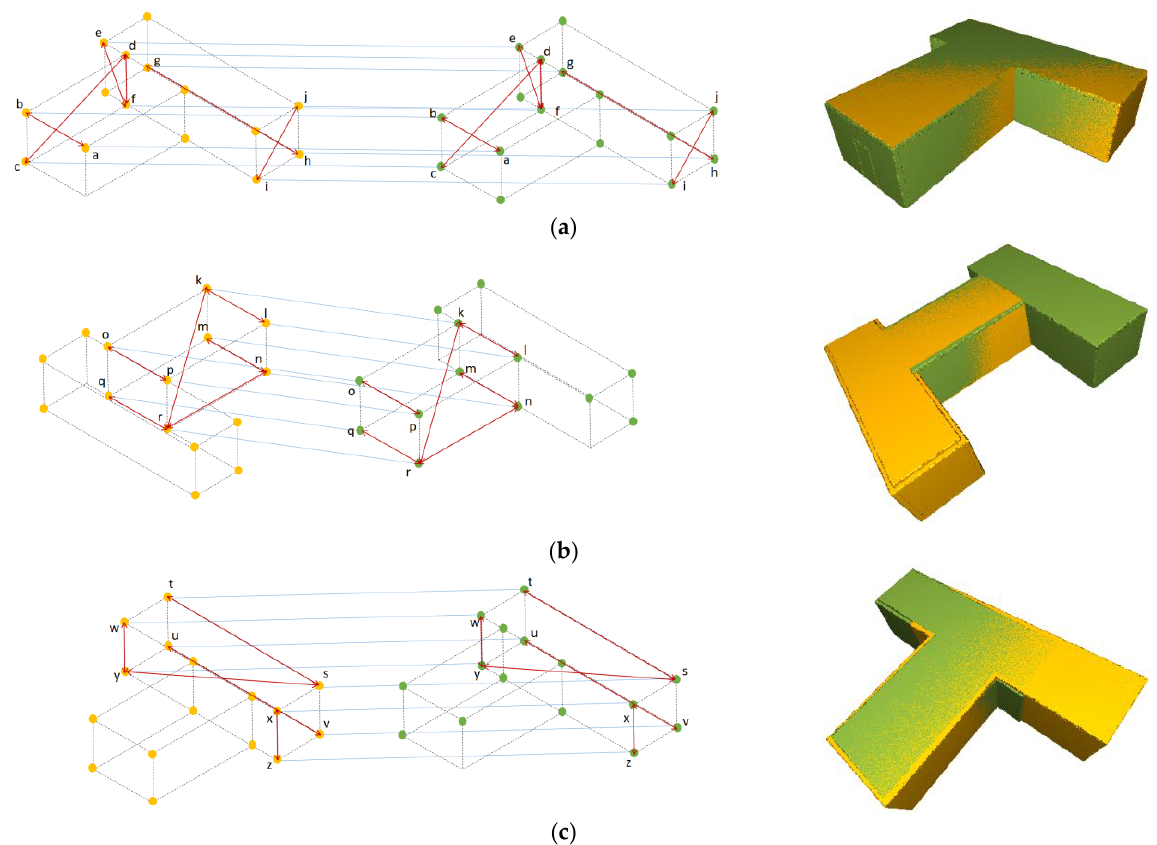
Figure 9. Potential matching points in the as-built ( left model ) and as-planned model ( right model ), clustered according to respective transformation parameters visualized next to them in terms of their corner points and 3D models ( a – c ).